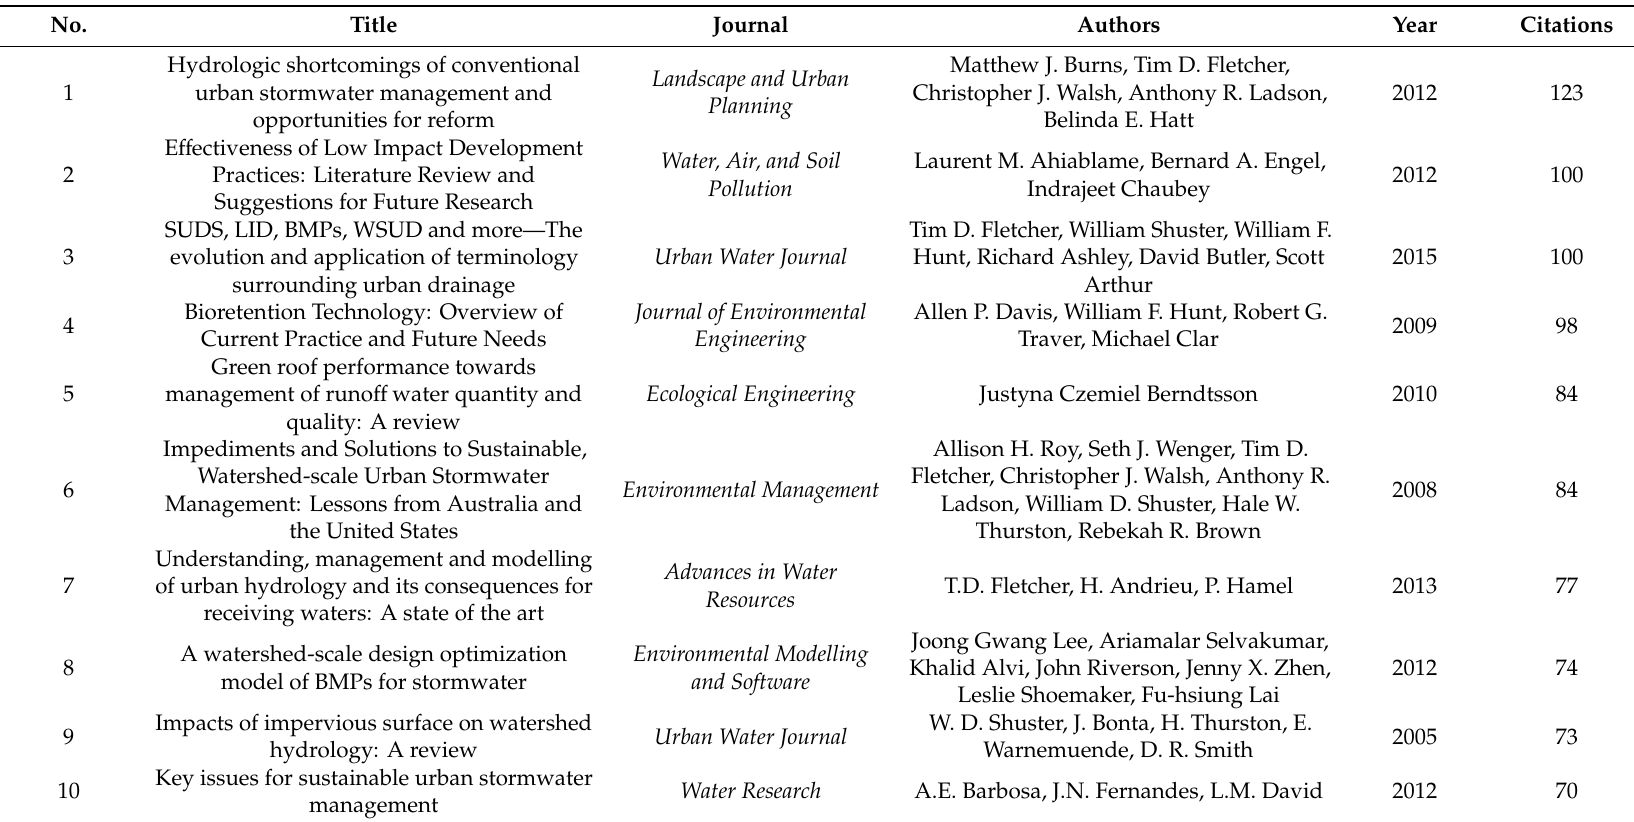
Table 3. Top 10 frequently co-cited documents in stormwater